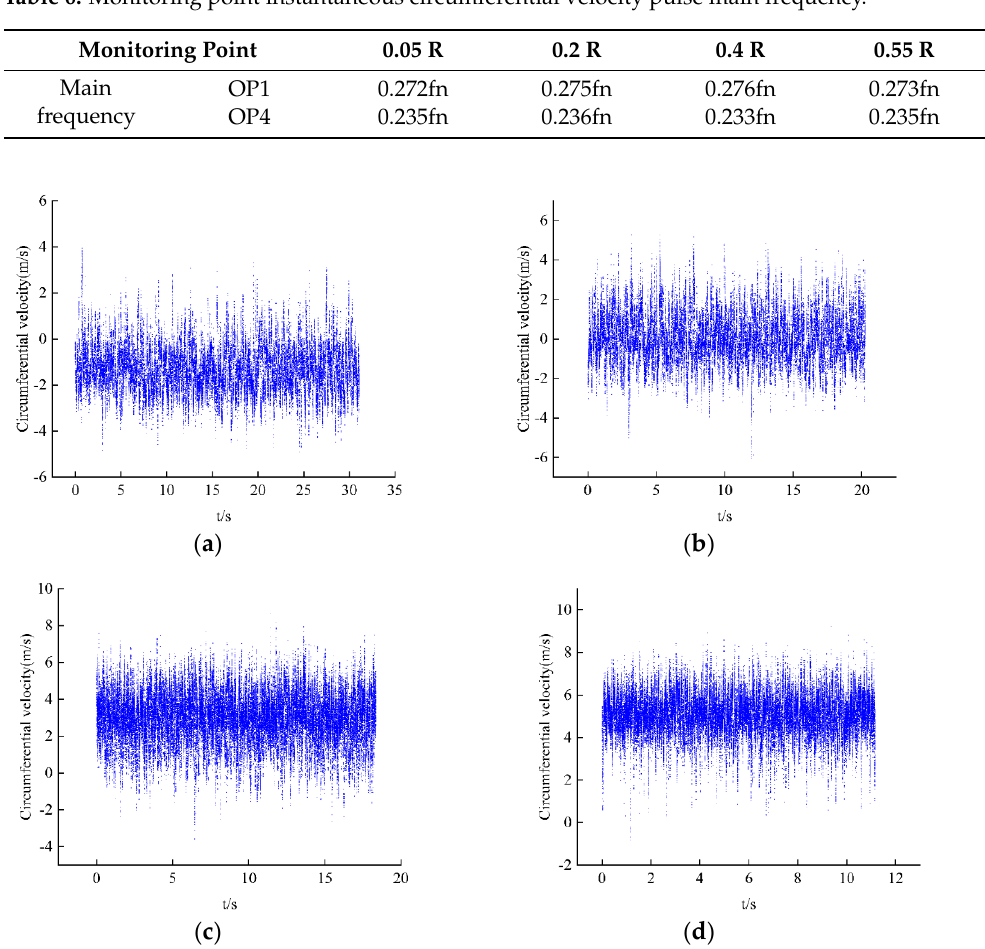
Figure 20. Circumferential velocity scatter diagram of OP1. ( a ) 0.05 R, ( b ) 0.2 R, ( c ) 0.4 R, and ( d ) 0.55 R. Table 6. Monitoring point instantaneous circumferential velocity pulse main